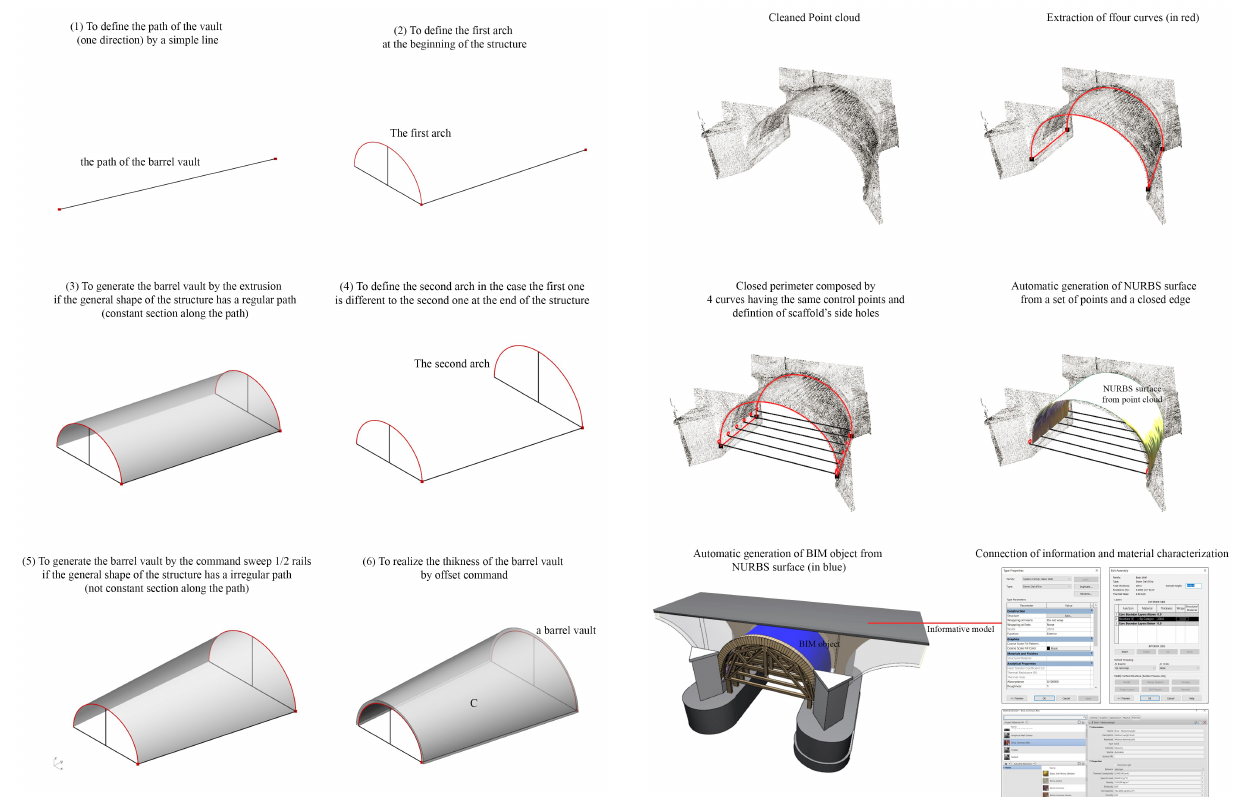
Figure 13. The research method: ‘how to model a barrel vault by GOG 10’. Thanks to GOG 10, The surface is transformed into a parametric BIM object. The thickness of each vault of the bridge has been intercepted from the main two facades and the thickness of the arches which close the